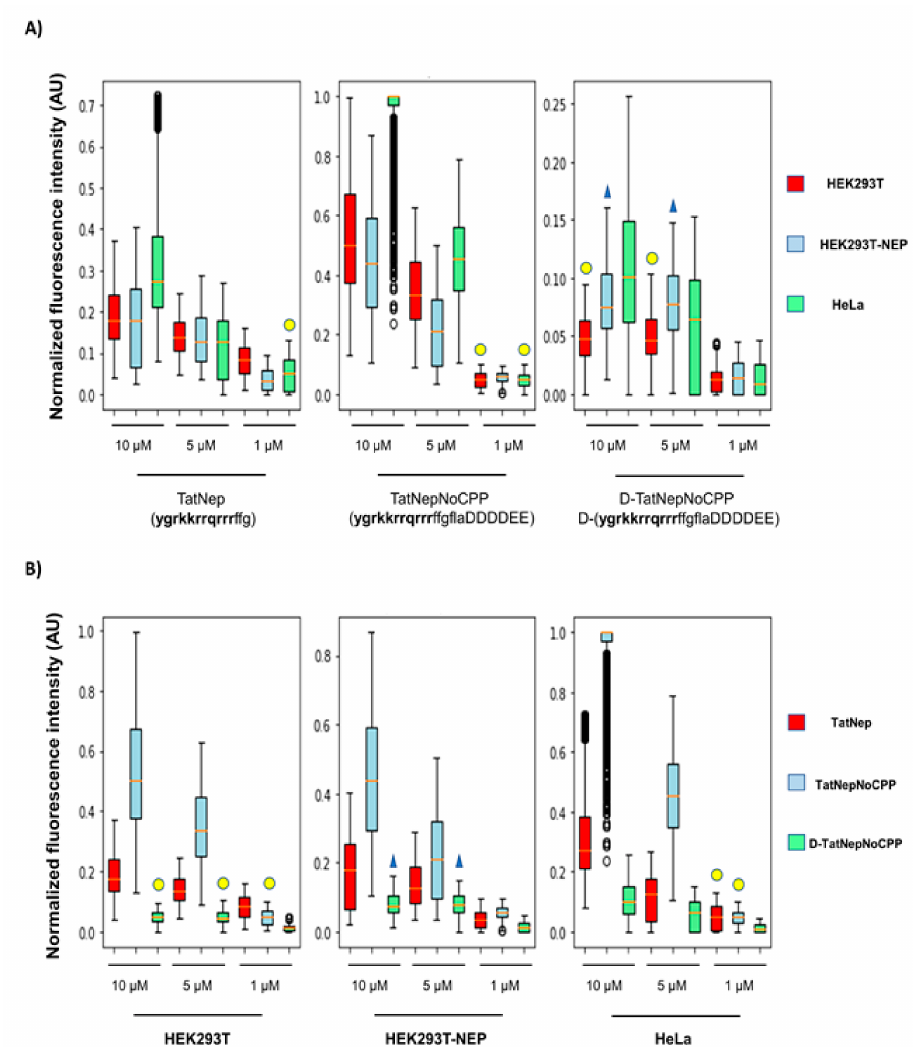
Figure 6. Internalization of activatable CPPs in mammalian cells. Normalized fluorescence intensity found in 2700 cells for each peptide. ( A ) Cell dependent internalization for HEK293T (red), HEK293T- NEP (blue) and HeLa (green). ( B ) Peptide dependent internalization for TatNep (red), TatNepNoCPP (blue) and D-TatNepNoCPP (green). Statistically similar distributions between the experiments are indicated with yellow circles or blue triangles ( p < 0.5, see Methods). The data represented in these boxplots are included in Table S4 and as Supplemental File S2 at http://bis.ifc.unam.mx/ ironbios/selmoonCPP (accessed on 21 July 2021). The data presented correspond with 1000